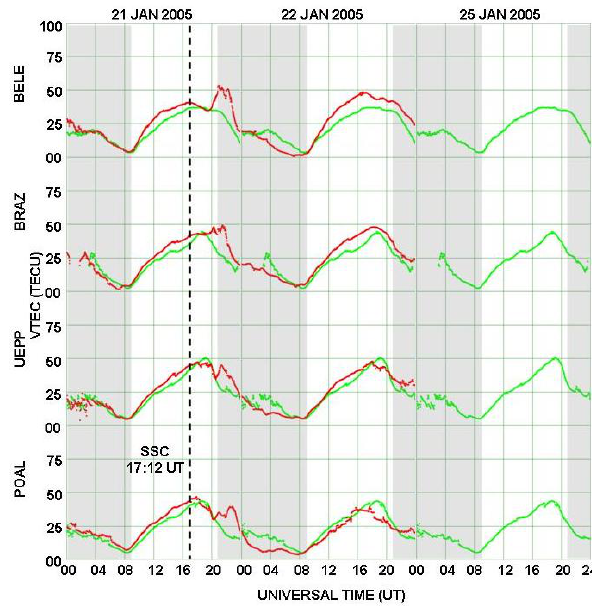
Fig. 7. Average vertical total electron content (VTEC) (TECU) ob- Figure 7 695 served at Belem (dip lat. 1.7 ◦ N), Brasilia (dip lat. 11.1 ◦ S), Presi- dent Prudente (dip lat. 14.6 ◦ S) and Porto Alegre (dip lat. 20.5 ◦ S) on 21 (red lines), 22 (red lines), and 25 (green lines) January 2005. The dark portions indicate nighttime for these four stations (21:00–